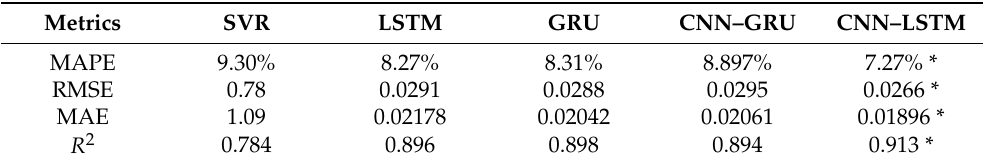
Figure 9. Prediction performance comparison among the different models under study over a week horizon on the traffic speed dataset. Table 3. Performance comparison of the different models under study in terms of the used state-of- the-art metrics on the traffic speed